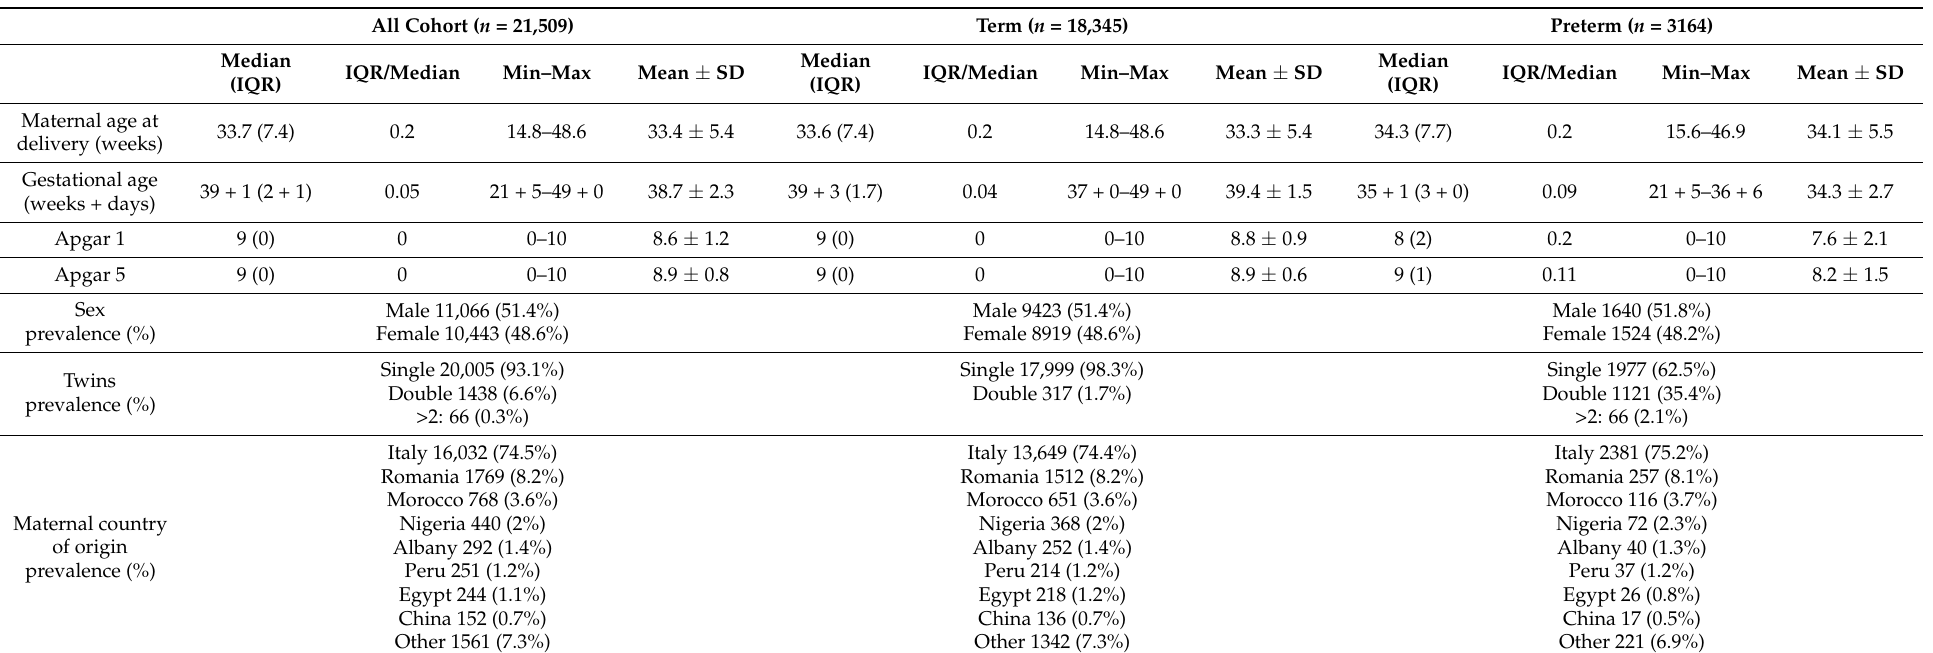
Table 1. Characteristics of the cohort under